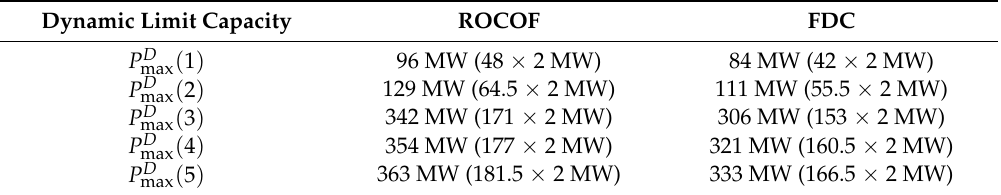
Figure 13. Frequency of Jeju power system at merit order 5 when the wind farm is lost. Table 3. Dynamic limit capacity of ROCOF and FDC for each merit